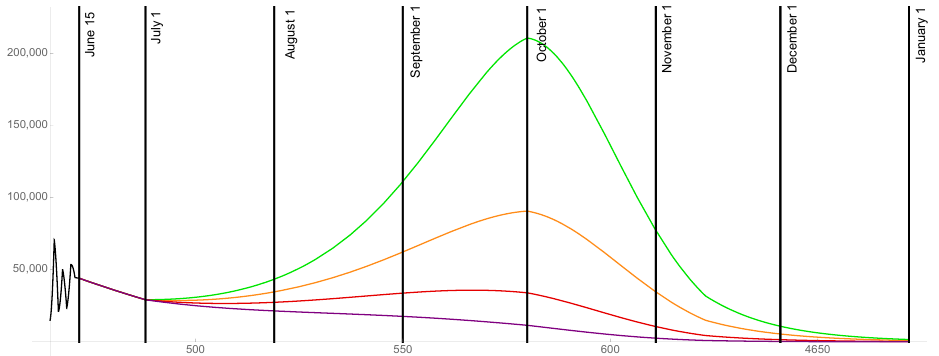
Figure 5. Model output from 7 March 2020 to the last day of daily reported cases data 15 June 2021. The graphs are S ( t ) (black), R ( t ) (magenta), U ( t ) (purple), CR ( t ) (blue), CU ( t ) (green), and CV ( t ) (orange). 3.1. 90% of the Population Becomes Fully Vaccinated After the last day t D = 15 June 2021, of daily reported cases, for 90% of the population to be ultimately vaccinated, the daily vaccination rate v daily ( t ) is v daily ( t ) = 1,000,000, 15 June 2021 ≤ t ≤ t Vmax = 11 November 2021 v daily ( t ) = 0, t Vmax = 11 November 2021 < t . For the case that 90% of the population is ultimately vaccinated, the transmission rates are graphed in Figure 6 and the daily reported cases are graphed in Figure 7 for ω = 0.015, 0.02, 0.025, 0.03.